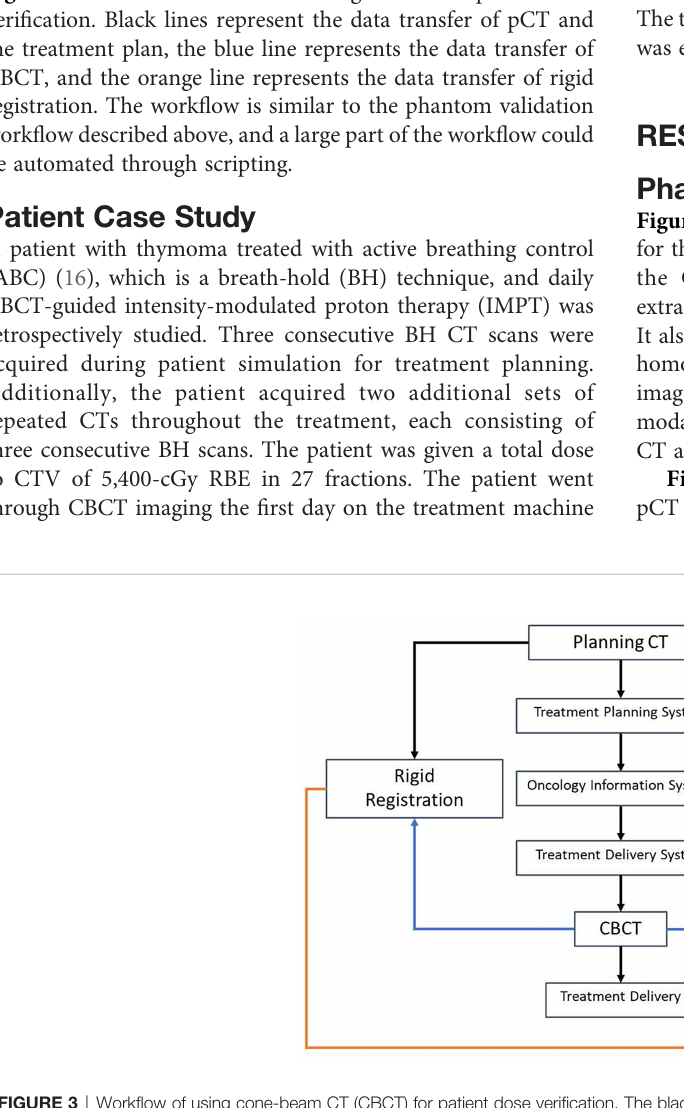
FIGURE 3 | Work fl ow of using cone-beam CT (CBCT) for patient dose veri fi cation. The black lines represent the data transfer of planning CT and the treatment plan, the blue line represents the data transfer of CBCT, and the orange line represents the data transfer of rigid